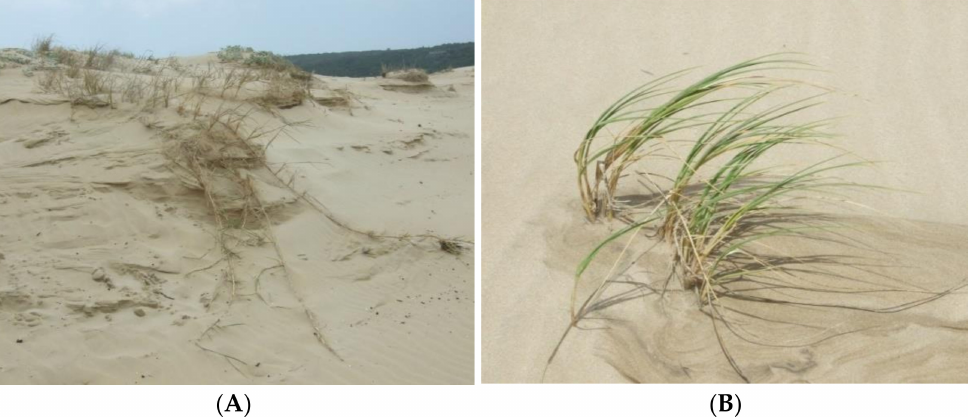
Figure 4. ( A ) Clumps of Agropyron distichum (sea wheat) on a wind eroded dune at Kenton-on-Sea. Note the exposed elongated rhizomes. ( B ) A young sea wheat plant in the wet sand.